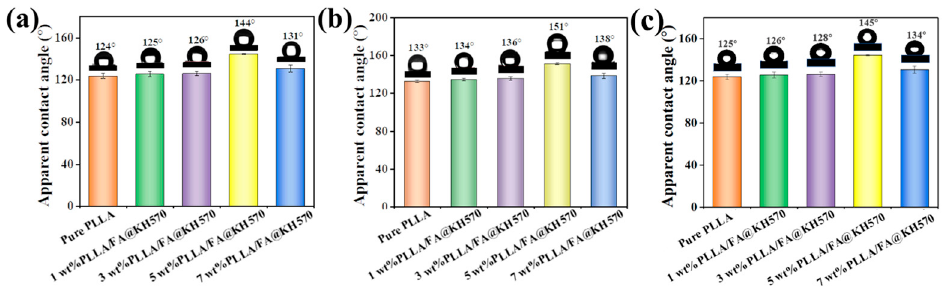
Figure 7. ( a ) Contact angles of neat PLLA and PLLA/FA@KH570 composites. ( b ) Contact angles of neat PLLA and PLLA/FA@KH570 composites with candle grease coating. ( c ) Contact angles of neat PLLA and PLLA/FA@KH570 composites after